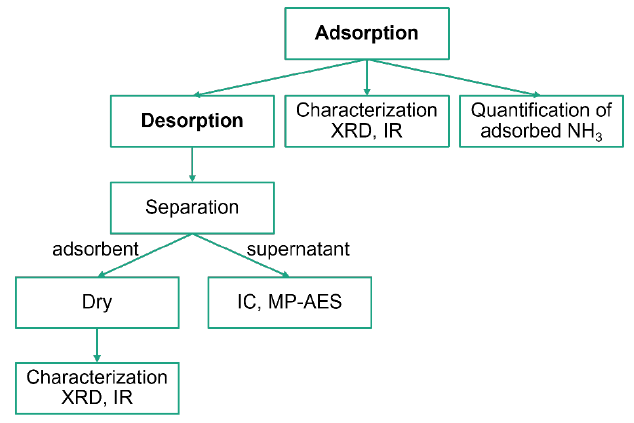
Figure 10. The experimental scheme.